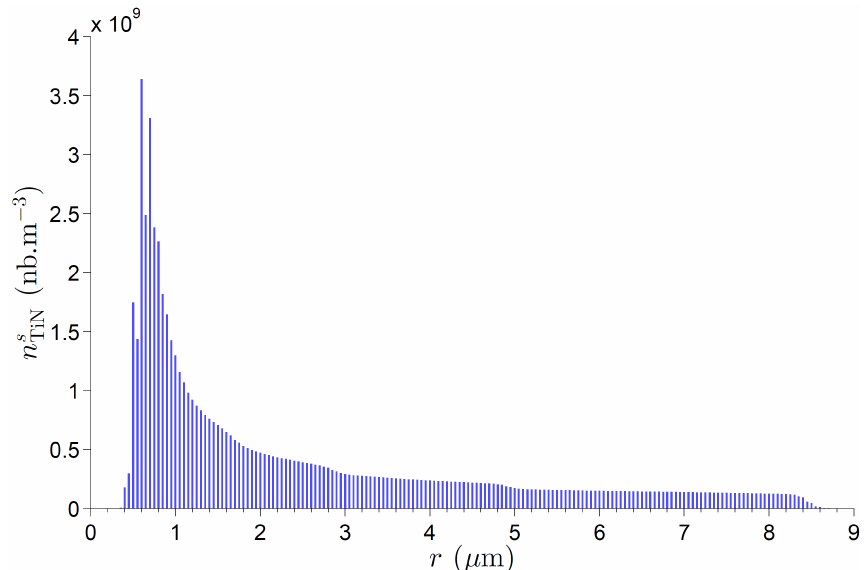
Figure 6. Final computed TiN size distribution in the solidified material.